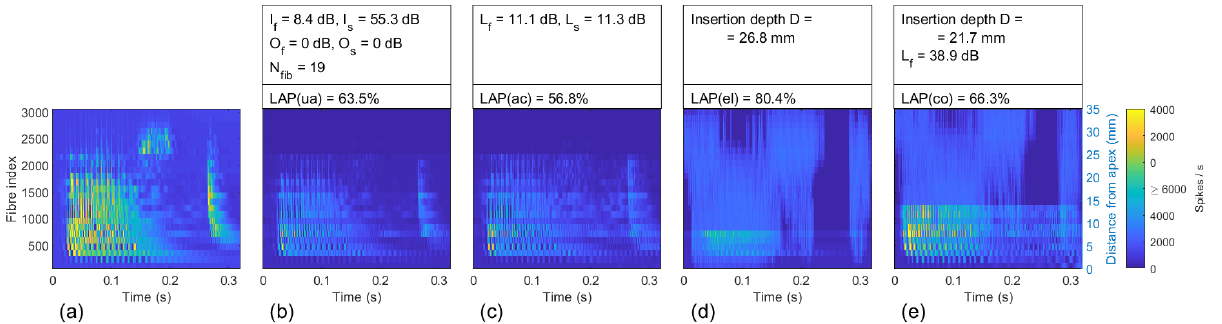
Figure 5. AN firing rates with regard to fiber index and time. The subject showed moderate IHCL at low frequencies and severe IHCL at high frequencies. ( a ) Normal hearing reference. ( b ) Unaided hearing, with hearing loss parameters (I f , I s , O f , O s , and N fib ). ( c ) Sole acoustical amplification, with amplification parameters (L f and L s ). ( d ) Sole electrical stimulation, with insertion depth of the CI. ( e ) Electrical stimulation combined with acoustic amplification, with insertion depth of the CI and amplification parameter L f . LAP refers to the cost-adjusted loss of action potentials.